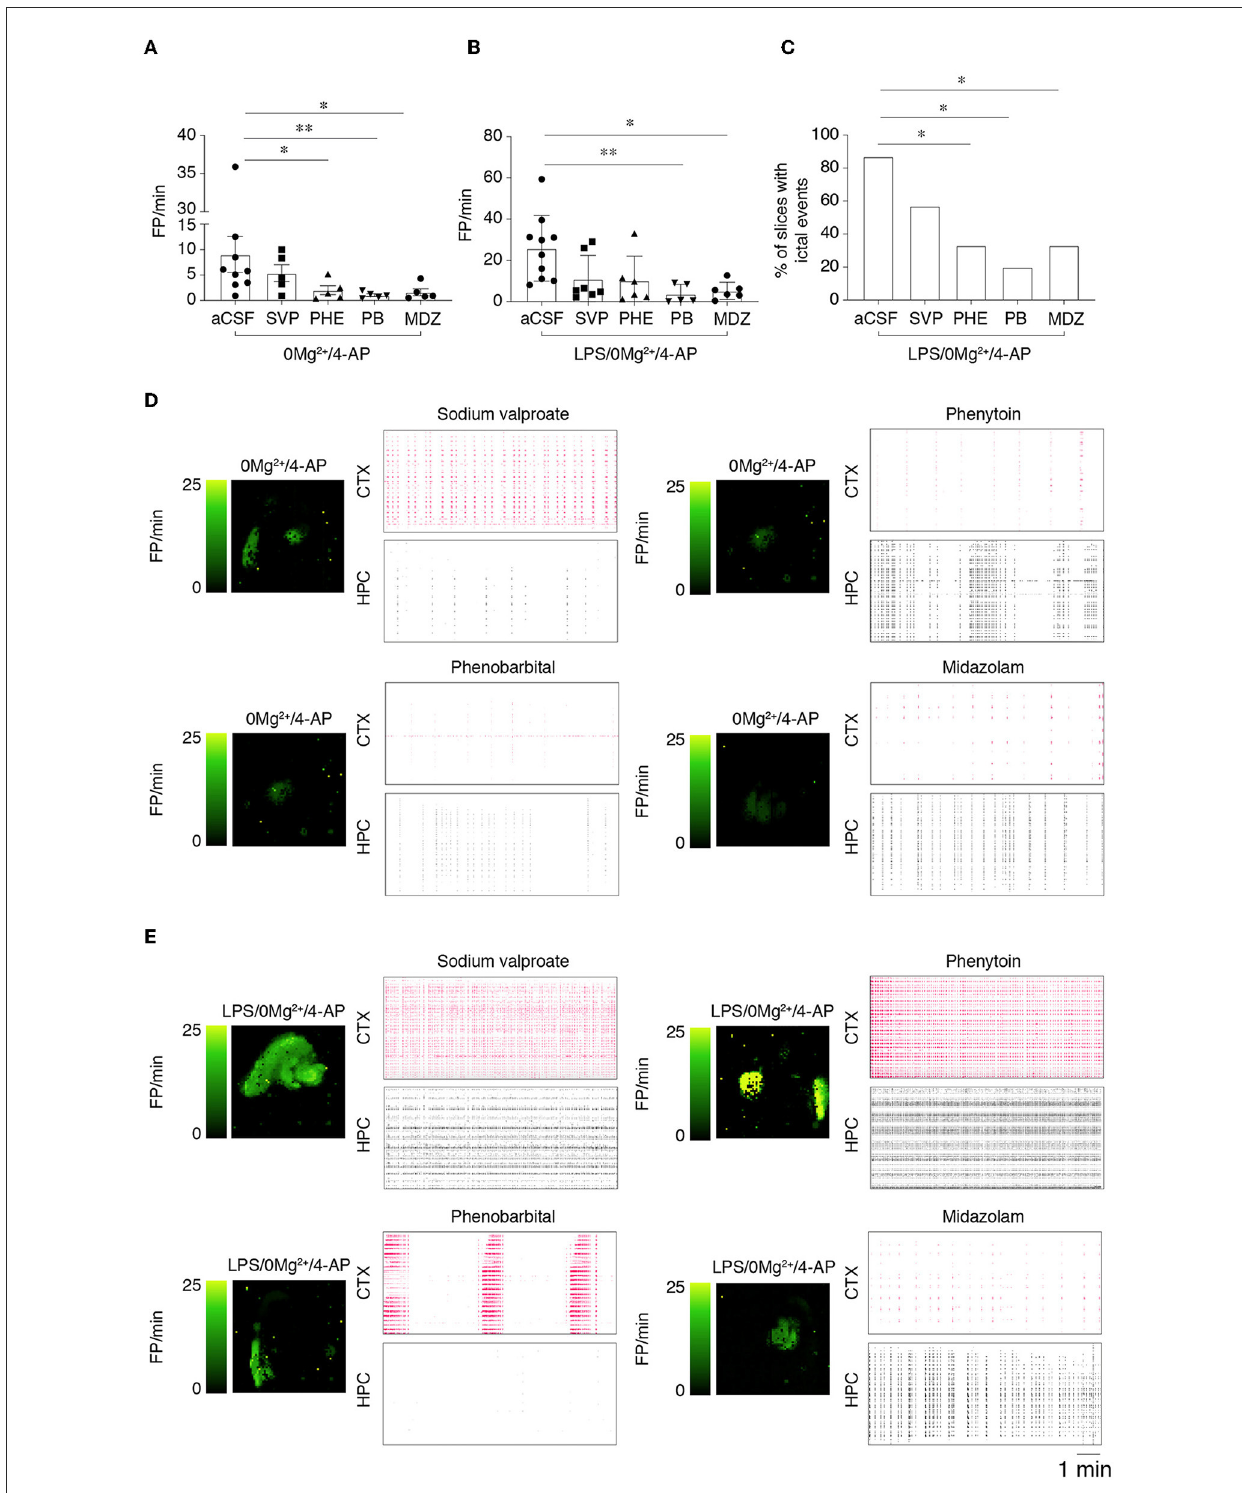
FIGURE4 Effect of ASMs on epileptiform activities. (A, B) Show the effect of 800 µ M sodium valproate (SVP), 50 µ M phenytoin (PHE), 100 µ M phenobarbital (PB) and midazolam (MDZ, 100 µ M) on field potential (FP) frequency in slices perfused with 0 Mg 2 + /4-AP (A) or pre-treated with LPS (B) (10 µ g/ml LPS for 30min, followed by 5min washout), then exposed to 0 Mg 2 + /100 µ M 4-AP for 40min. Quantification of epileptiform activity was done during T2 (20–30min from the start of 0 Mg 2 + /4-AP perfusion) in the area of higher activity in each slice. Data are presented as mean ± SEM and single values ( n = 5–7 slices/experimental group) * p < 0.05; ** p < 0.01 by Mann–Whitney test vs. respective control slices (aCSF, no ASMs added). (C) Shows the incidence of the combination of ictal and SE events in LPS-pretreated slices in the various experimental groups. * p < 0.05 vs. 0 Mg 2 + /4AP by Chi-square test. (D, E) Depict representative activity maps (higher FP frequency corresponds to lighter green color) and raster plots in temporal cortex (CTX) and hippocampus (HPC) after addition of the various ASMs to slices perfused with 0 Mg 2 + /4-AP ± LPS. SVP, sodium valproate; PHE, phenytoin; PB, phenobarbital, MDZ,